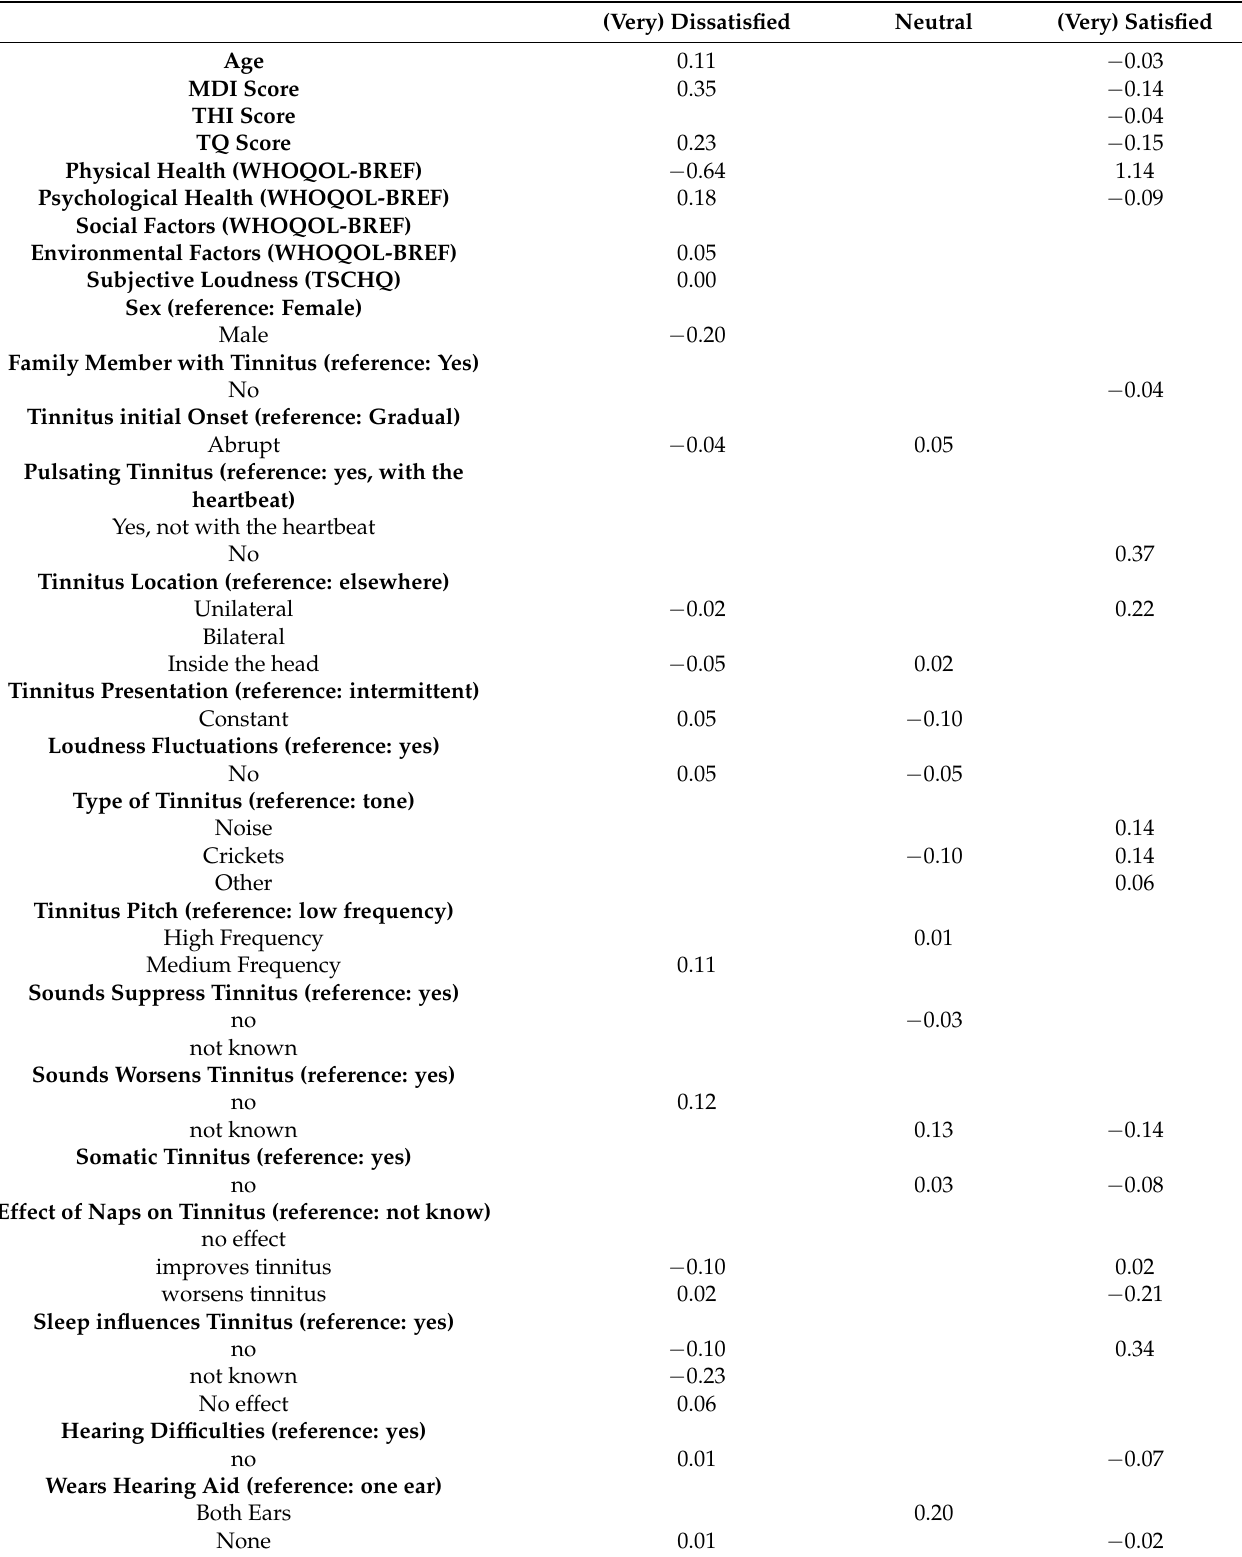
Table 2. Coefficients of multinomial regression with Lasso regularization. Dashed lines represent predictors shrunk to 0 by the model. For categorical values, the log-odds of being classified into one of the three groups is compared to its reference, which is highlighted for each categorical